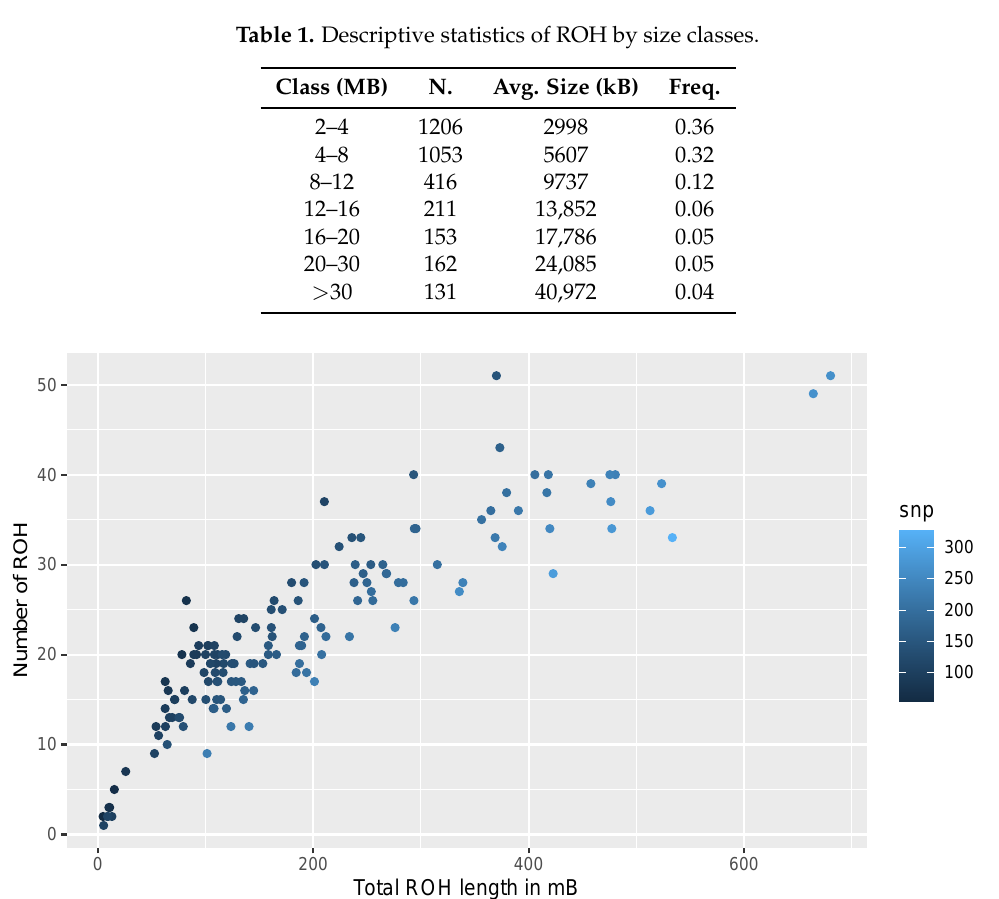
Figure 3. Total length of ROH vs number of ROH per animal in the Maremmana cattle dataset. ROH length is expressed in MB.